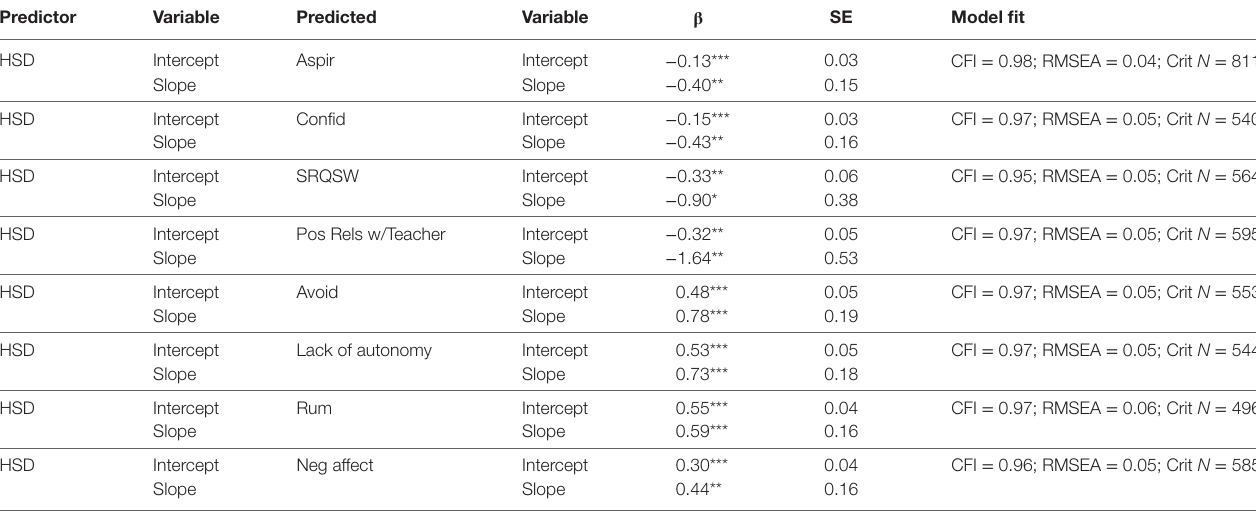
Table 3 | Parallel process latent growth models of HSD predicting the eight outcomes. Predictor